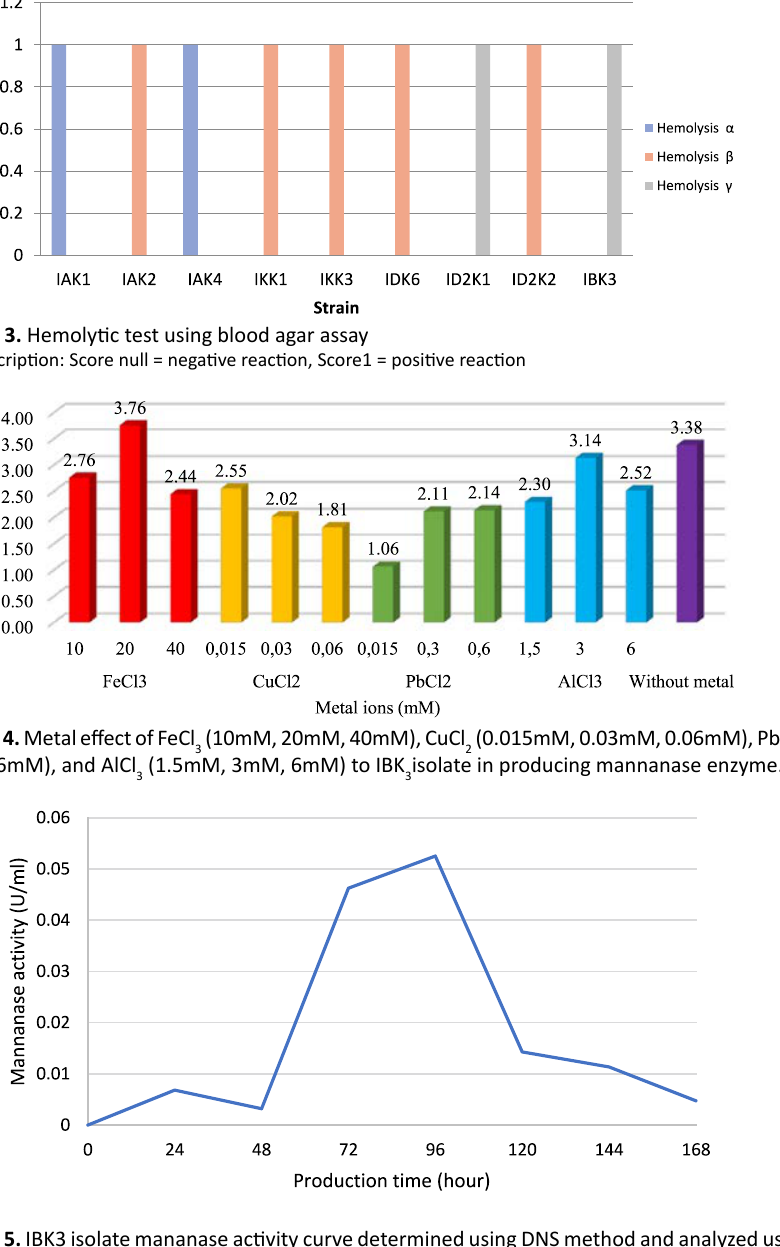
Fig. 5. IBK3 isolate mananase activity curve determined using DNS method and analyzed using spectrophotometer at l